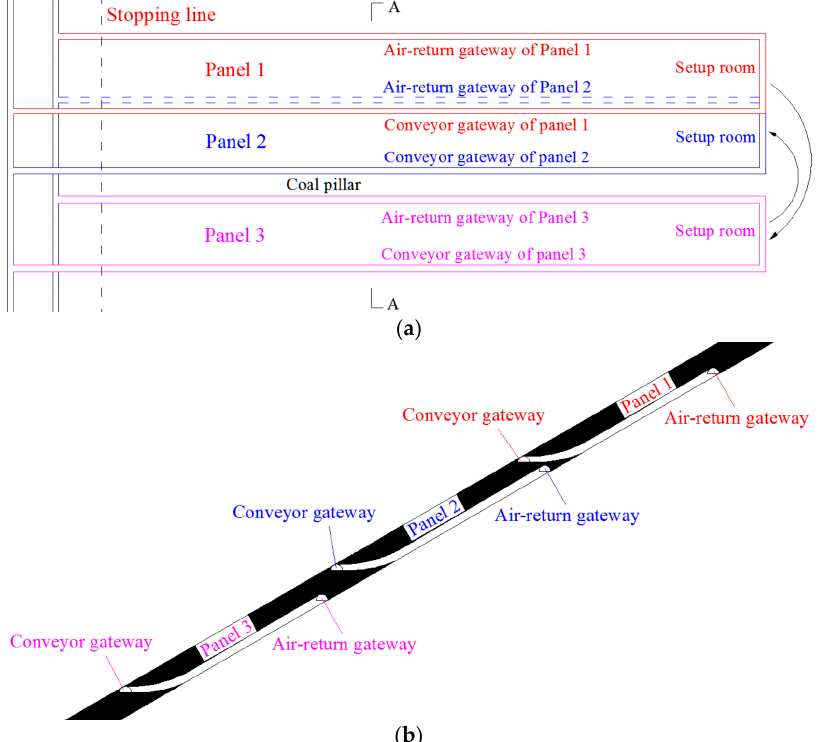
Figure 6. Panel continuance plans for three panels. ( a ) Plan view; ( b ) A-A section view.